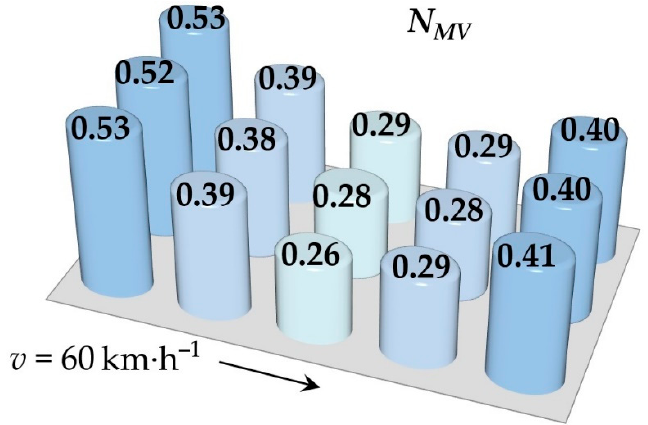
Figure 11. The distribution of the index N MV for a speed of 60 km ∙ h − 1 : the “Modification I” parameters.